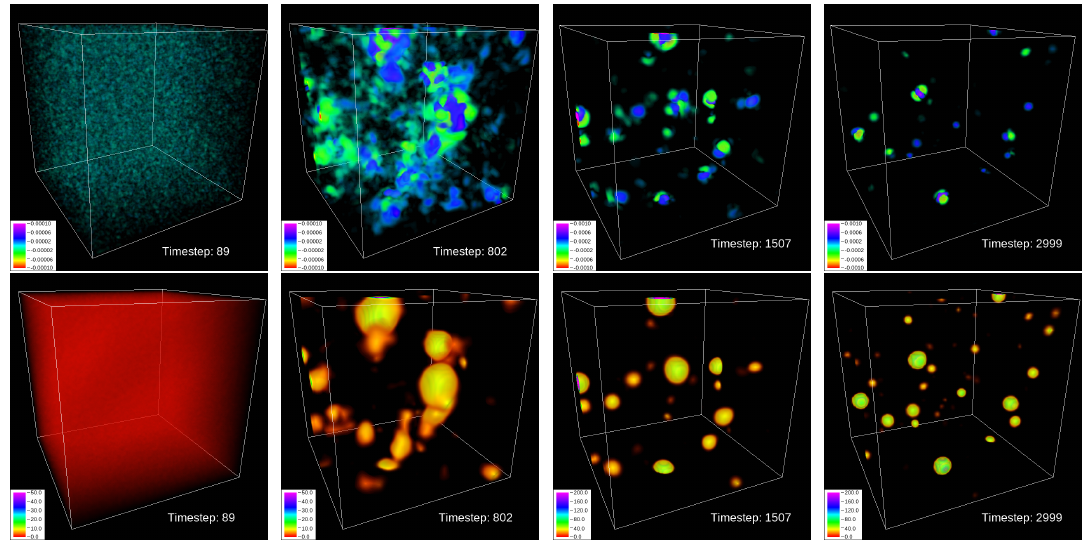
Figure 1 . Evolution of the charge density (top row) and energy density (bottom row) in an FRW universe with Gaussian random initial perturbations from inflation. We see that complex CSQs can naturally arise in the early universe with the logarithmic potential. Note that, for either the charge density or the energy density, the numerical scales for the color bars are different for the first and the last two subplots: the numerical cutoff for the charge density is 10 − 4 at TimeStep 89 and 802 and is 10 − 3 at TimeStep 1507 and 2999; the numerical cutoff for the energy density is 50 at TimeStep 89 and 802 and is 200 at TimeStep 1507 and 2999. 1 TimeStep ’ 1 . 95 /m . The initial box size equals 0 . 05 H − 1 , H being the initial Hubble